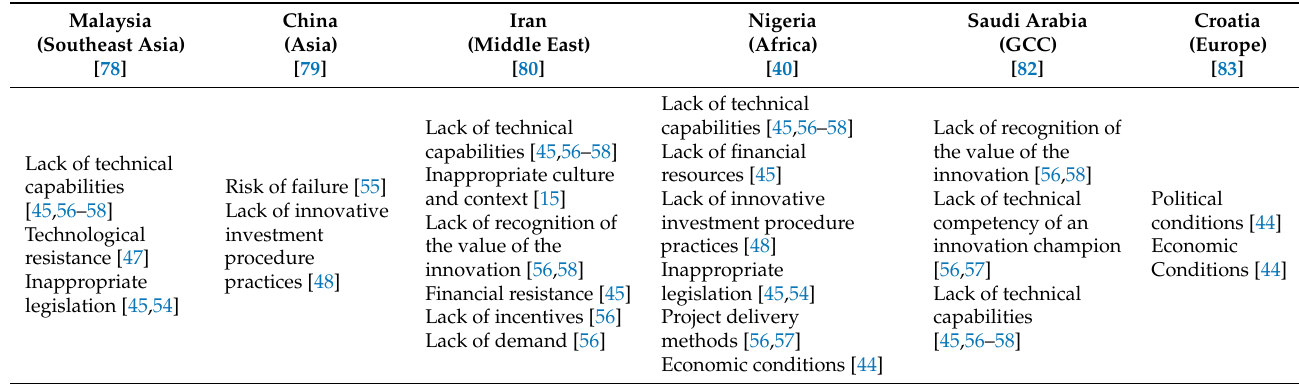
Table 6. Barriers to BIM innovation in developing